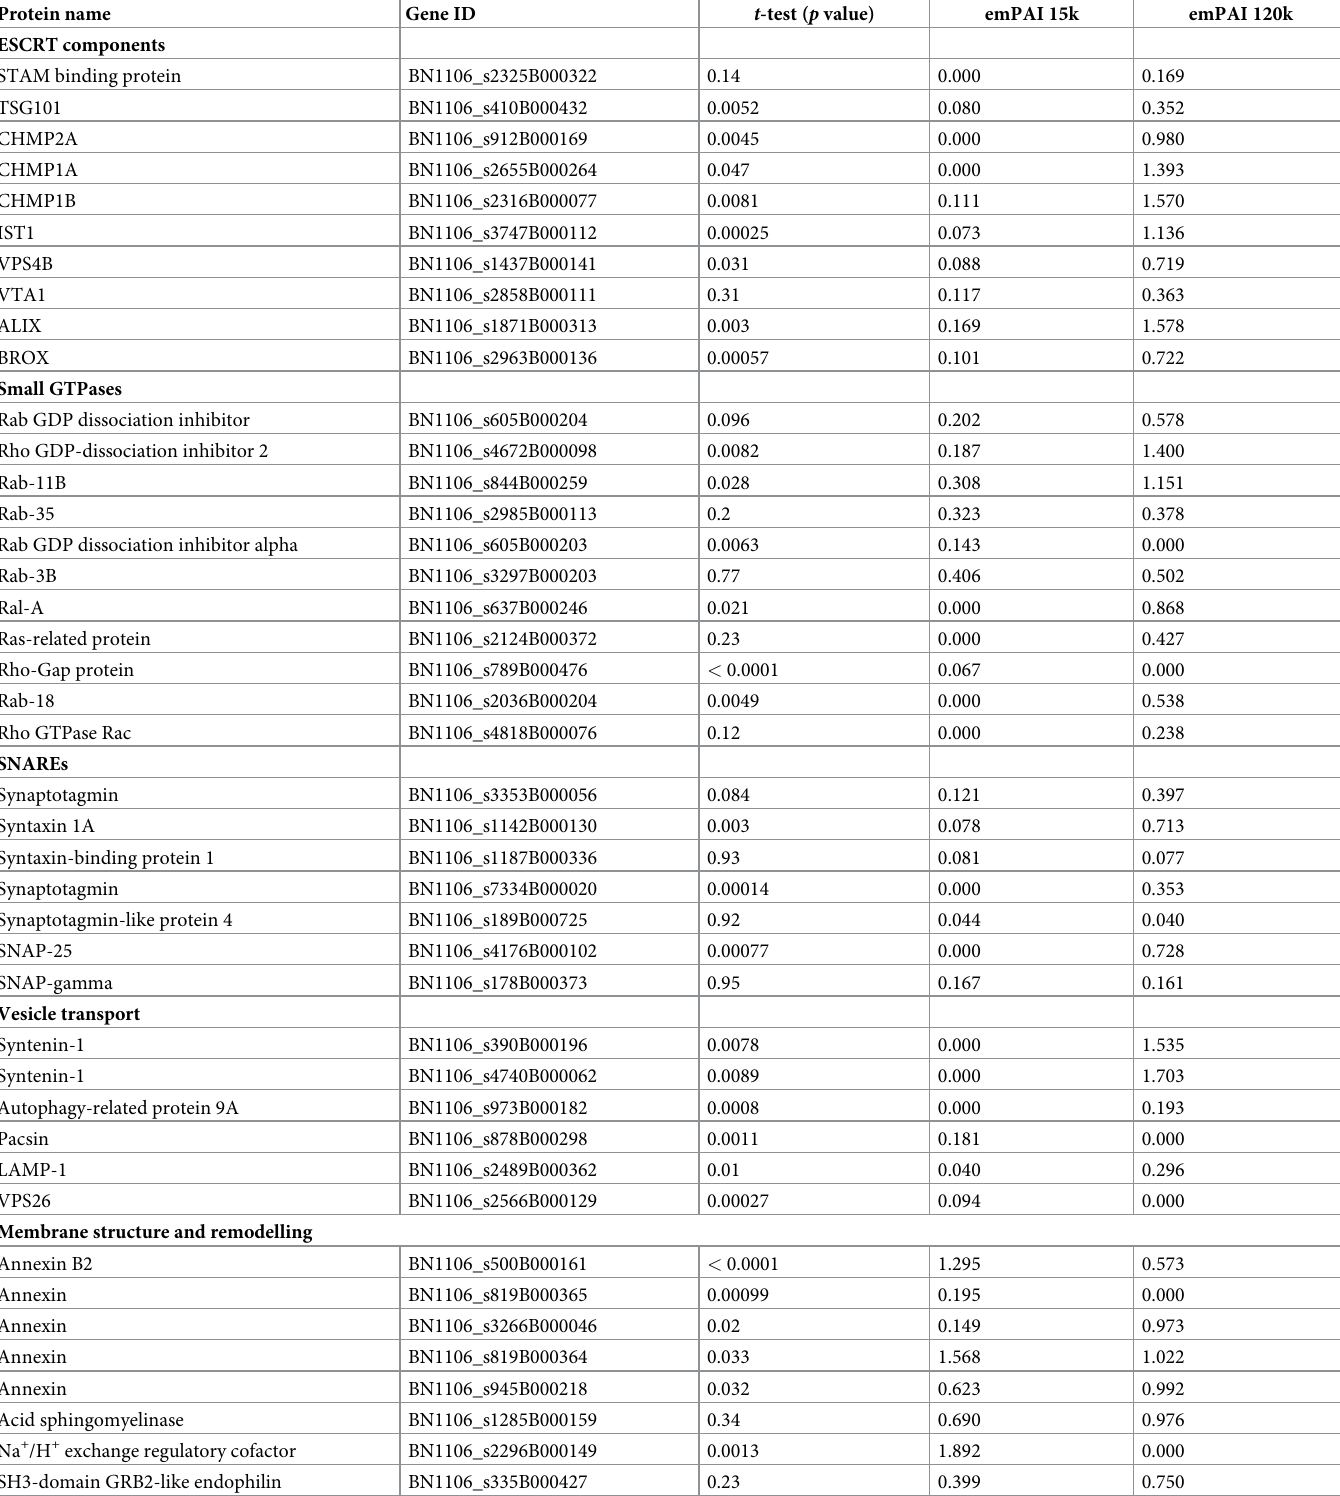
Table 3. Proteins associated with EV biogenesis and vesicle trafficking found on the surface of F . hepatica